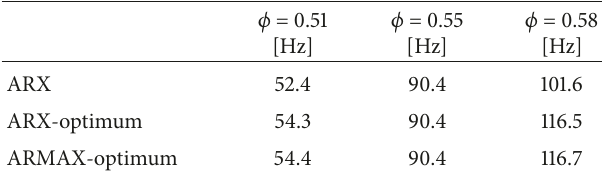
Figure 19: Spectral entropy spatial distribution within a blade pas- sage with and without injection. Table 4: Identification results for dynamics in blade